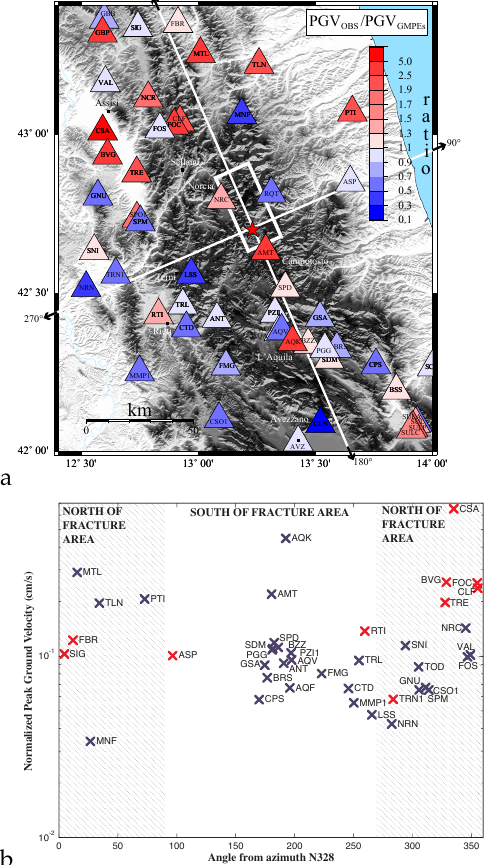
Figure 3. (a) PGA ratio (PGAOBS/PGAITA10) areal distribution at the 98 considered stations of RAN. (b) PGA versus azimuth in a modified geographic refer- ence system obtaining by rotating the geographic North of 32 degrees counter clockwise (white lines). Blue symbol indicates “A” and “B” site, red symbol refers to “C” and “D” sites.